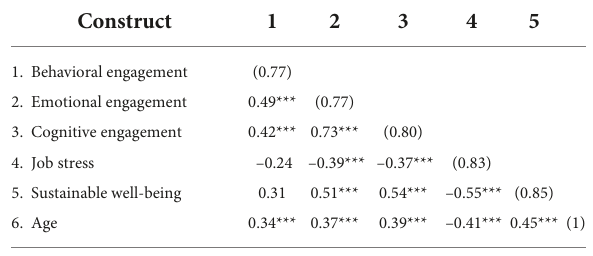
TABLE 4 Discrimination validity